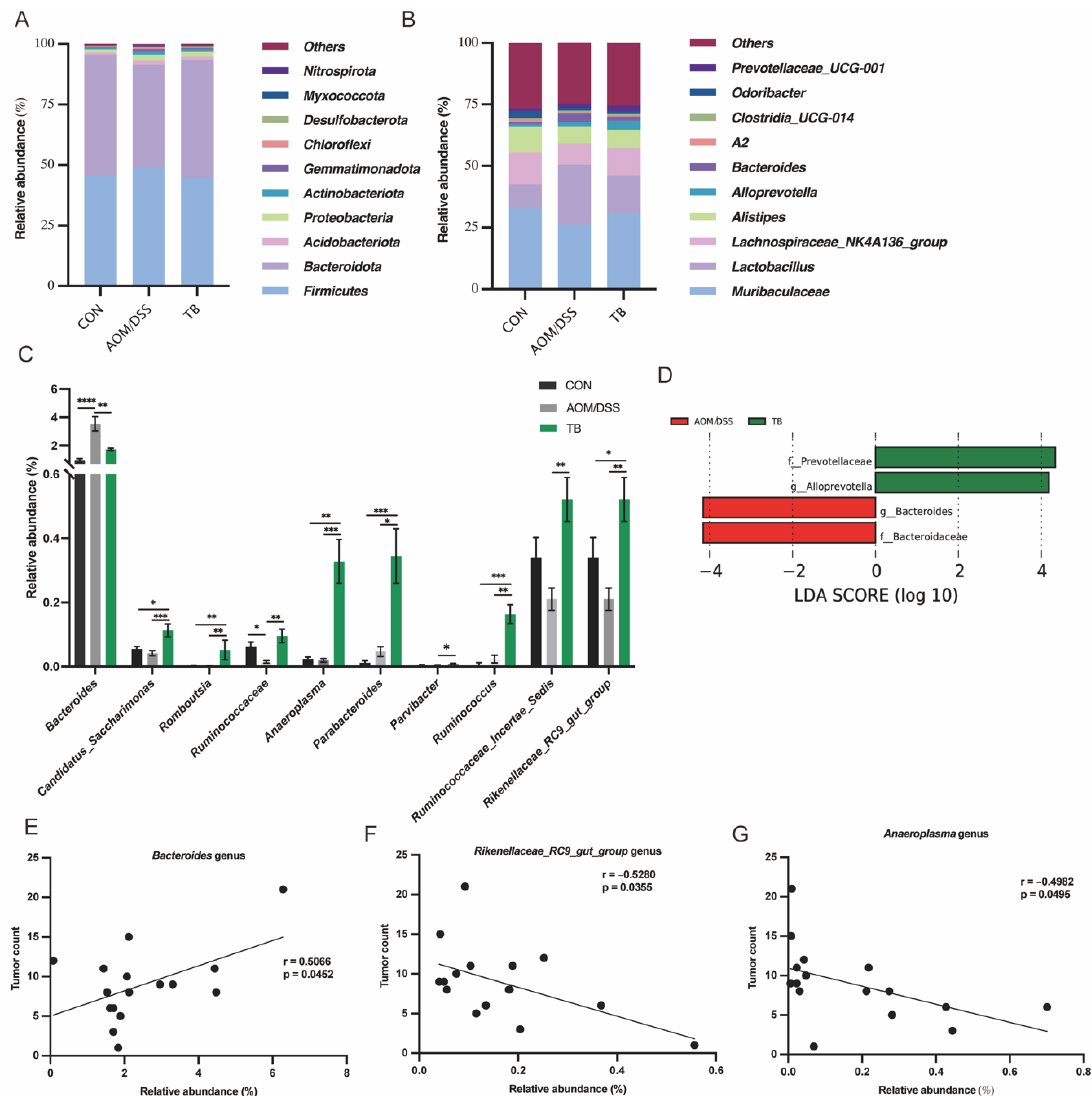
Figure 5. TB altered fecal microbiota abundance. Taxonomical composition at ( A ) phylum and ( B ) genus level. ( C ) Relative abundance in different genus. ( D ) Linear discriminant analysis (LDA) of Effect Size (LEfSe) analysis. Correlation analysis of tumor count and abundance of ( E ) Bacteroides , ( F ) Rikenellaceae_RC9_gut_group , and ( G ) Anaeroplasma . Data are presented as mean ± SEM. * p < 0.05, ** p < 0.01; *** p < 0.001, **** p < 0.0001.